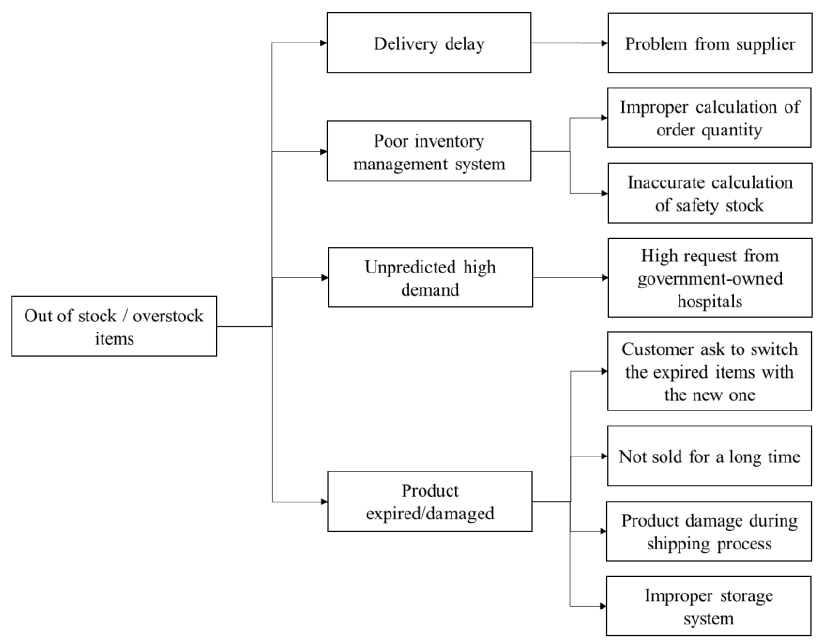
Figure 3: Tree Diagram for Stockout / Overstock